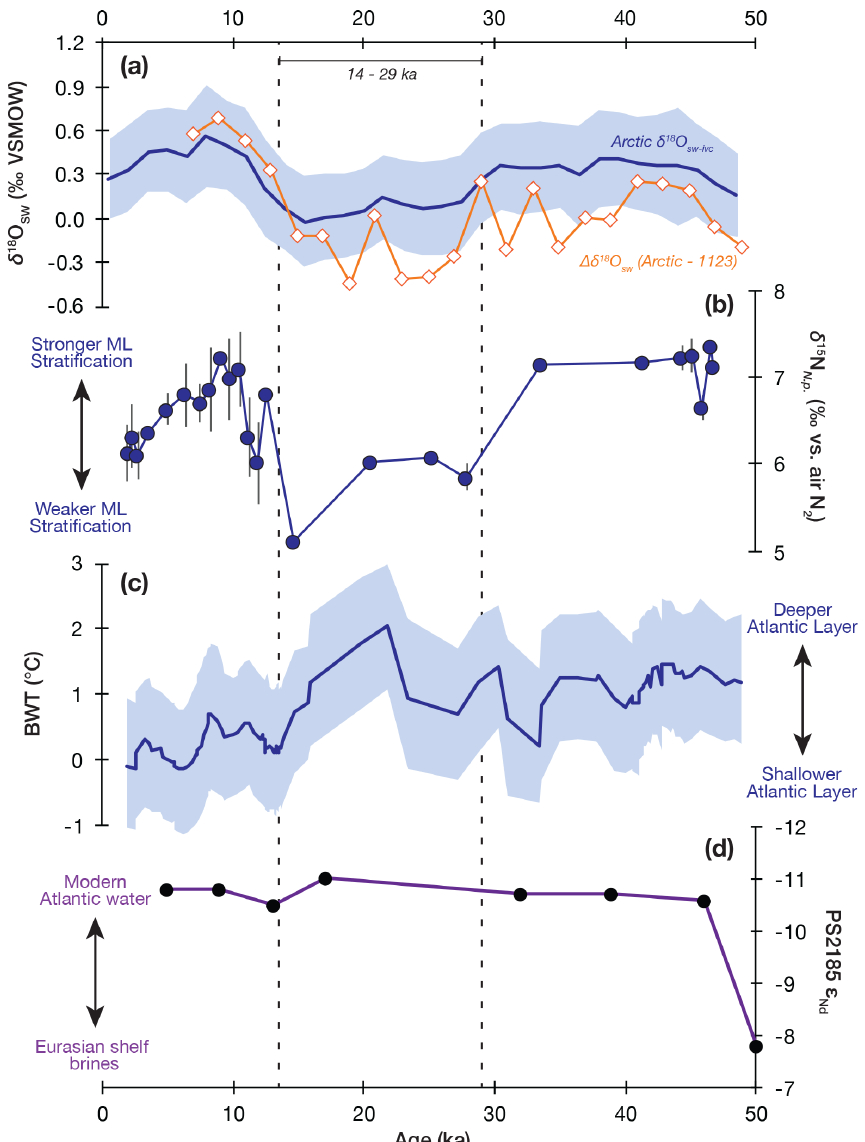
Figure 9. Low intermediate-to-deep-Arctic δ 18 O sw during MIS 2 and records speaking to its cause. (a) Arctic δ 18 O sw-ivc (blue line and shading) and (cid:49)δ 18 O sw normalized to Site 1123 (orange line and diamonds). (b) N. pachyderma -bound δ 15 N from Lomonosov Ridge Site AOS94-B28 (Farmer et al., 2021; 2023). (c) Arctic BWT stack from Krithe Mg / Ca (Cronin et al., 2012). (d) PS2185-3/6 metal oxide ε Nd (Haley et al., 2008). Interpretive framework for each proxy is shown next to the record. The interval from 14 to 29ka is marked by vertical dashed